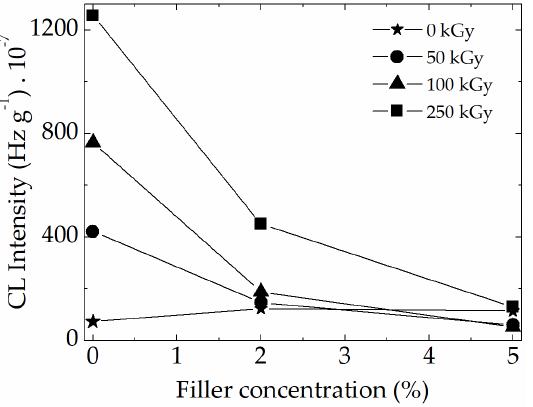
Figure 5. Modification of CL intensity in PP modified with PbZrO 3 nanoparticles [125].